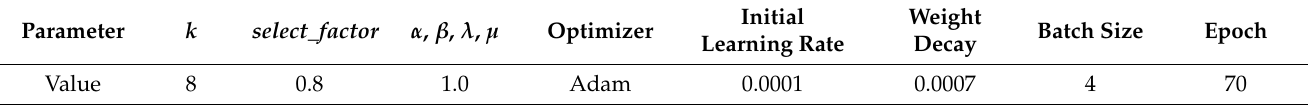
Table 3. Value setting of the network parameters. The values of α , β , λ , and µ are the initial